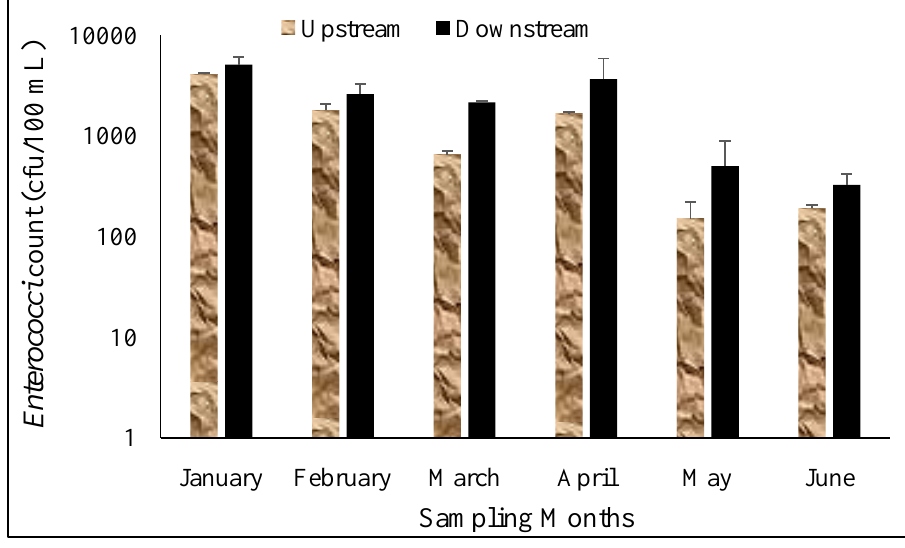
Figure 5. Enterococci count in the upstream and downstream of Mvudi